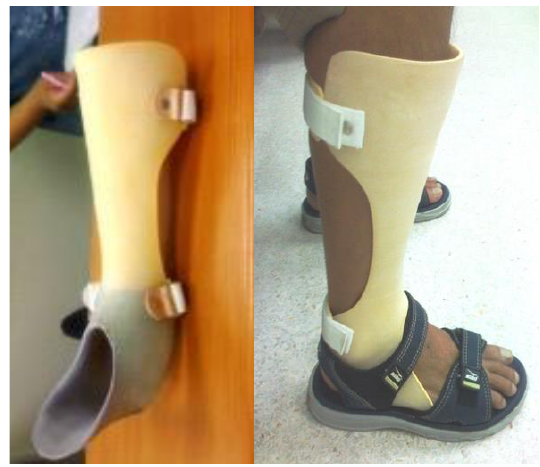
Figure 2. AAFO, anterior ankle foot orthosis